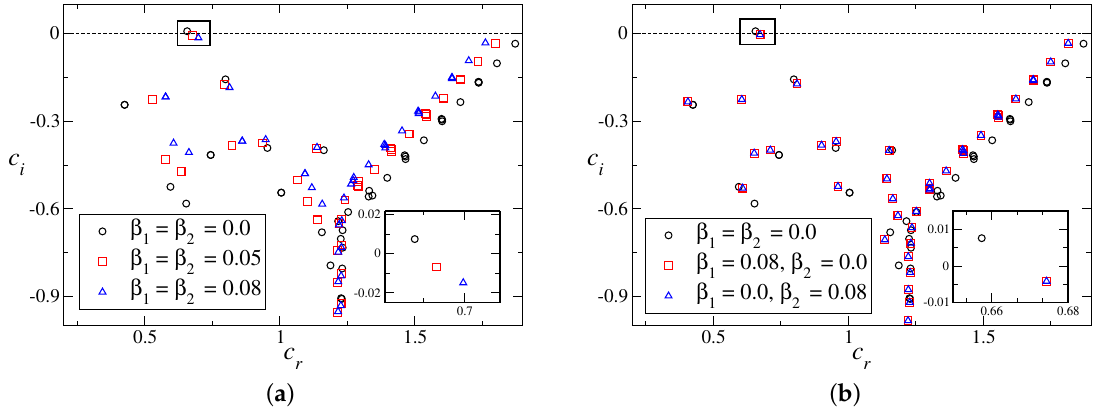
Figure 7. Eigenspectra for σ 1 = 0, σ 2 = 0.2 and Re = 1000: ( a ) with symmetric slip ( β 1 = β 2 ); and ( b ) with non-symmetric slip ( β 1 (cid:54) = β 2 ).